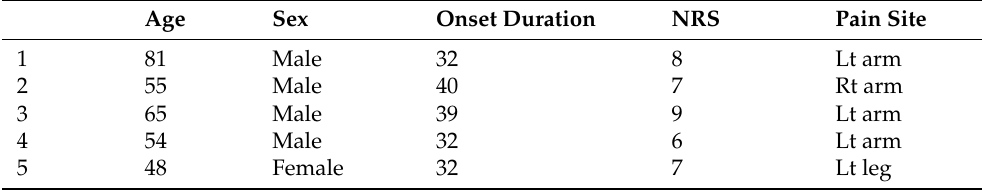
Table 2. The information of patients with CRPS who were included in this